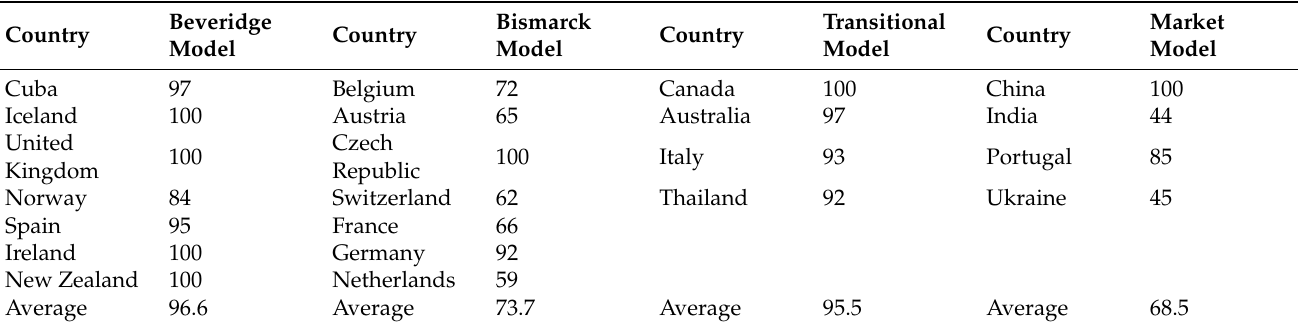
Figure 3. Comparison of the results of the effectiveness of the medical system and resistance to the pandemic according to the model of the organization of the health care system. Source: constructed by the authors. Table 2. Results of the frontier analysis for different countries of the world according to the model of the health care system